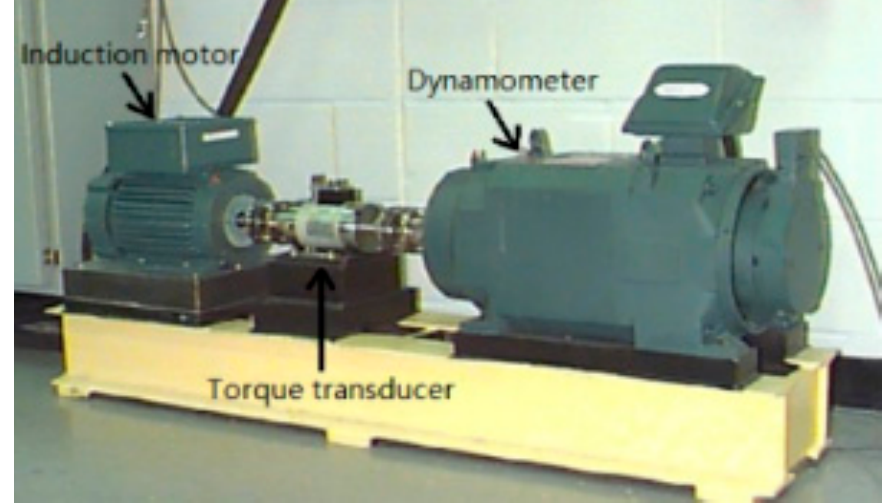
Figure 8. Roller bearing test rig [36].